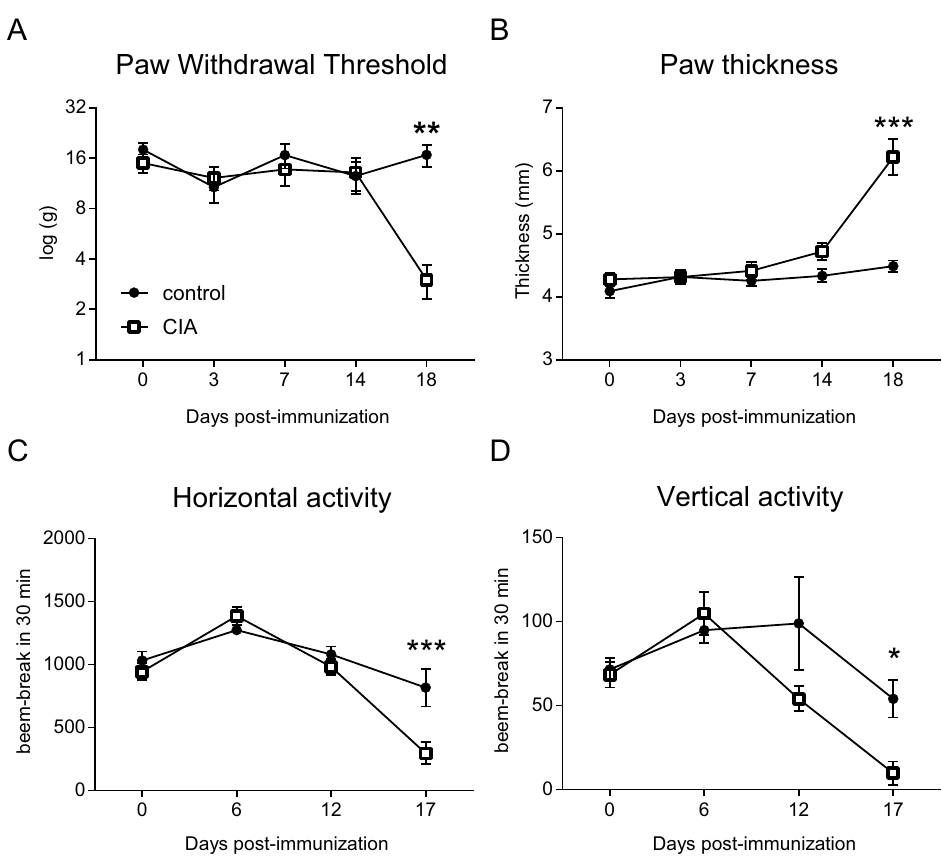
Fig 1. Increased pain and paw swelling accompanied by low locomotor activity in the rat CIA model. Paw withdrawal thresholds (A) were reduced, and paw thickness increased (B) 18 days after collagen-induced arthritis in CIA rats (n = 9) compared to control (n = 9). Both horizontal (C) and vertical (D) activity, which were measured during the dark cycle before testing pain, decreased on the night of day 17 post immunisation in CIA group compared to control. Results represent mean ± SEM. � p < 0.05, �� p < 0.01, ��� p < 0.001, significantly different from